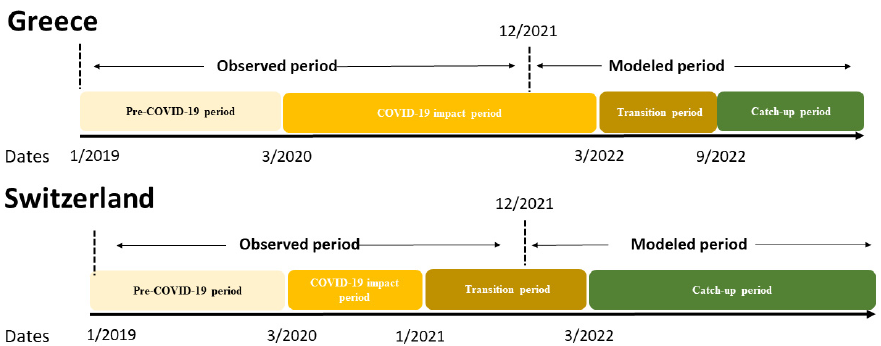
Figure 1. Schematic outline of the analysis for each